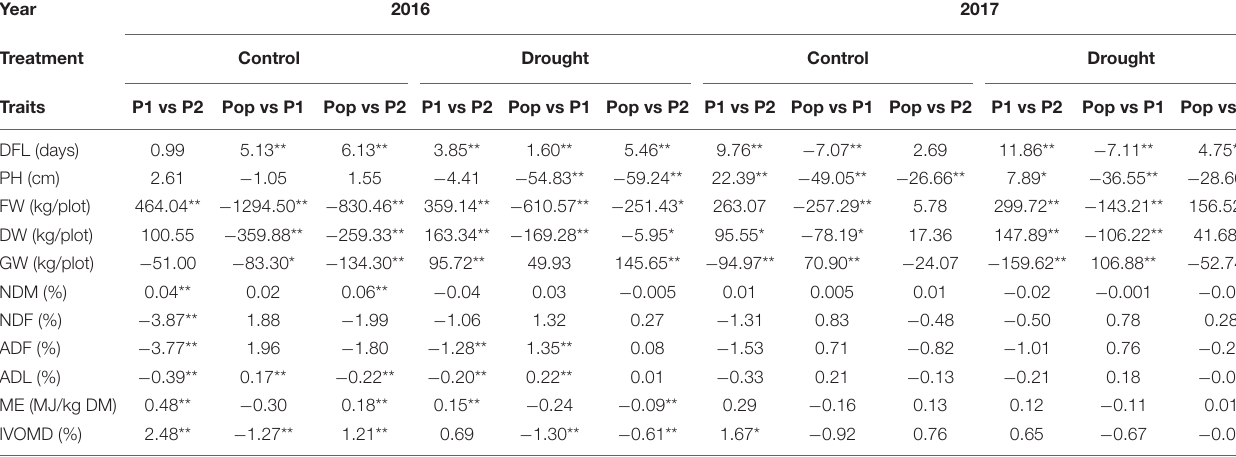
TABLE 2 | Mean comparisons between contrasting parents and population under both the treatments for each year.